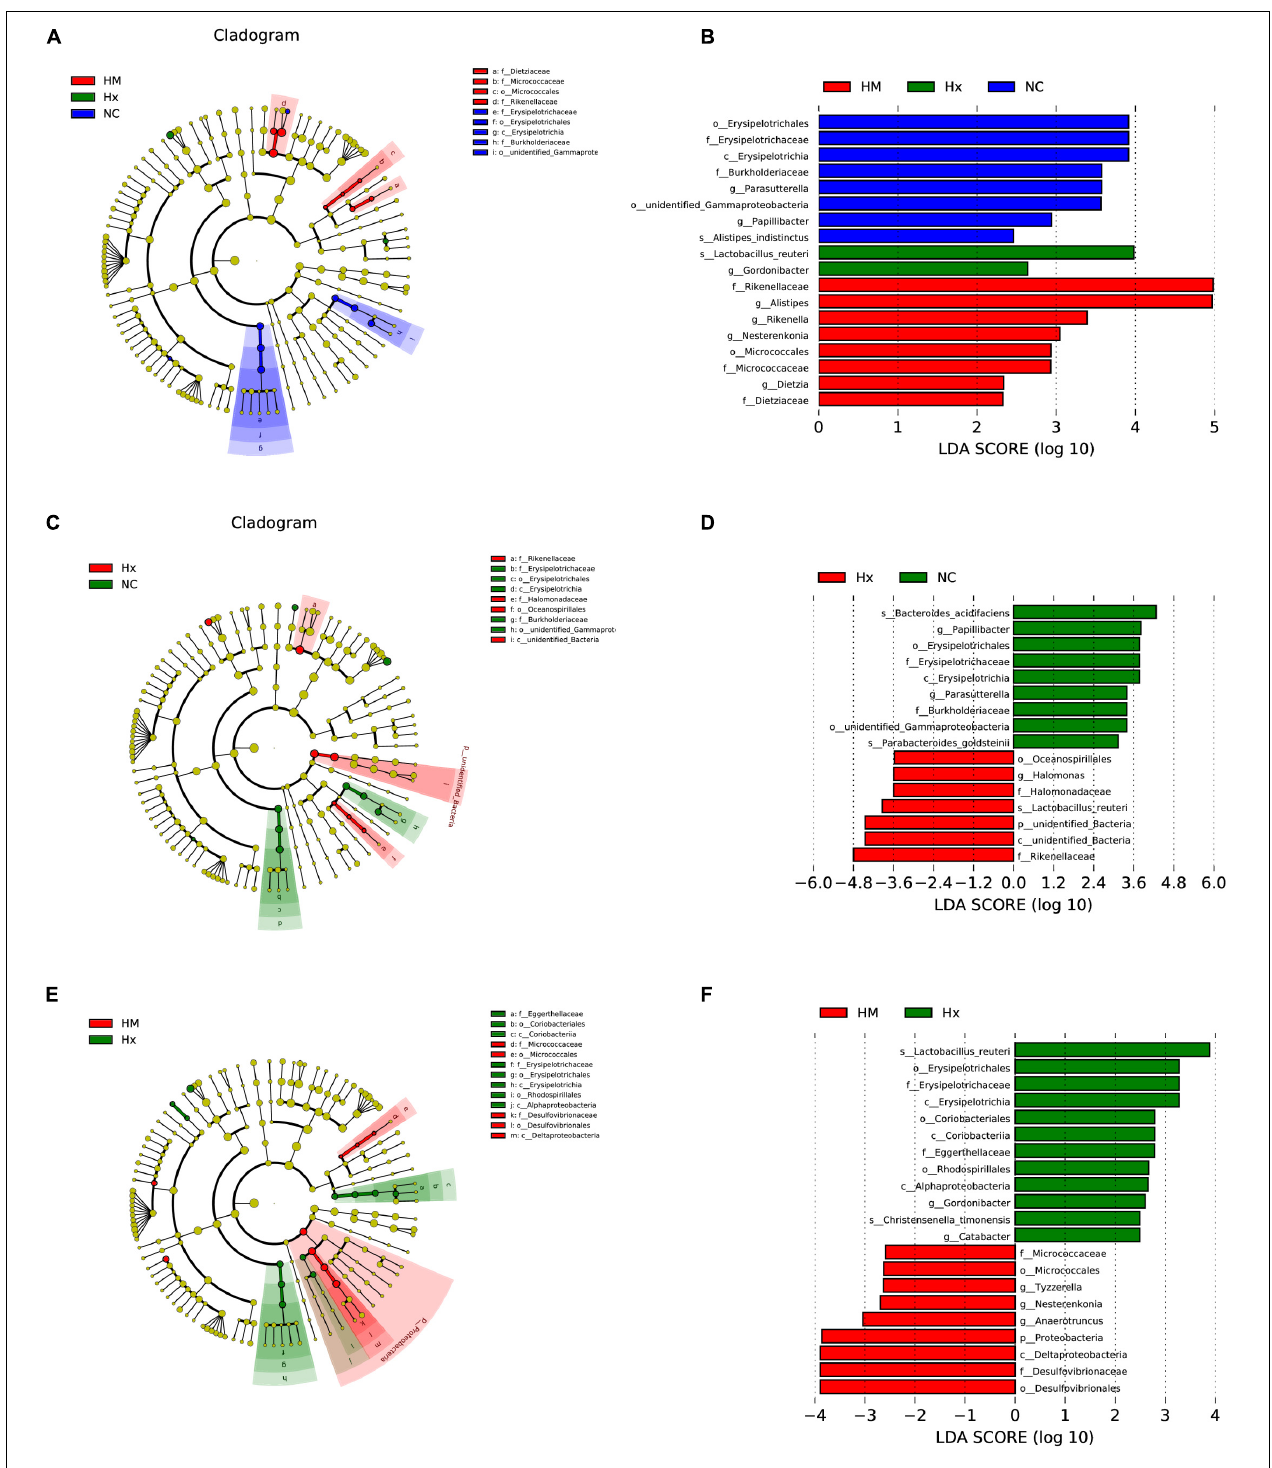
FIGURE 4 | LDA of the microbial community variation. (A) The cladogram represents the phylogenetic relationship of significant OTUs associated with NC, Hx and HM. (B) Linear discriminant effect size (LEfSe) analysis was performed (alpha value ≥ 0.05, logarithmic LDA score threshold ≥ 2) on all three groups together. (C) The cladogram represents the phylogenetic relationship of the significant OTUs associated with NC and Hx. (D) Linear discriminant effect size (LEfSe) analysis was performed (alpha value ≥ 0.05, logarithmic LDA score threshold ≥ 2) on NC and Hx. (E) The cladogram represents the phylogenetic relationship of the significant OTUs associated with Hx and HM. (F) Linear discriminant effect size (LEfSe) analysis was performed (alpha value ≥ 0.05, logarithmic LDA score threshold ≥ 2) on Hx and HM. NC, Vehicle control; Hx, hypoxia-induced group; HM, MSC-treated group. n = 4–5.